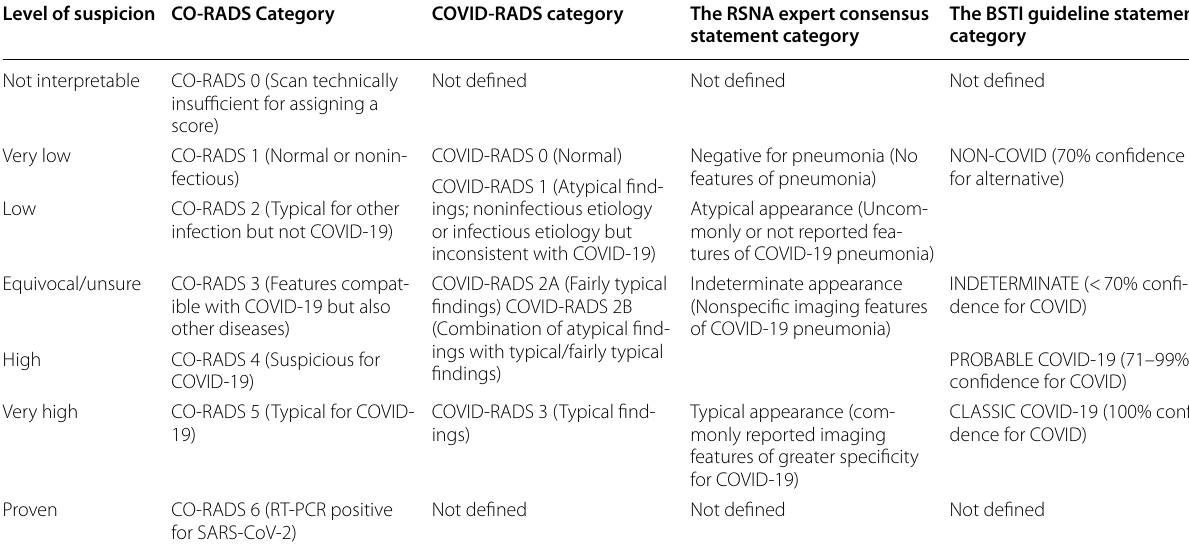
RSNA Radiological Society of North America, CO-RADS the COVID-19 reporting and data system, COVID-RADS the COVID-19 imaging reporting and data system, BSTI British Society of Thoracic Imaging, RT-PCR Real-time reverse transcription polymerase chain reaction